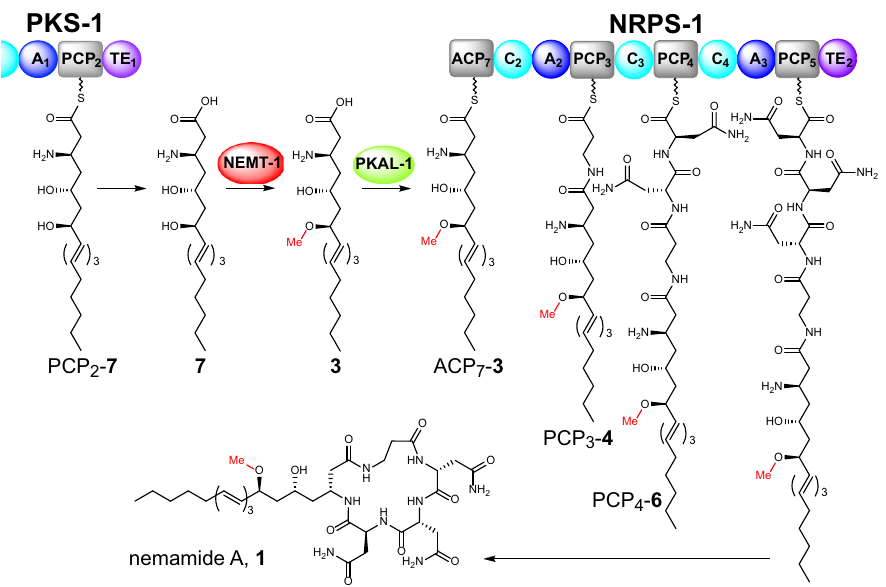
Fig. 6 Proposed model for the biosynthesis of the nemamides. The methylated intermediate 3 is activated by PKAL-1 as the adenylate and loaded onto the ACP 7 domain of NRPS-1 in order to biosynthesize nemamide A, 1 . An analogous pathway biosynthesizes nemamide B, 2 . Our data suggest that PKS-1 produces and releases 7 , which is then methylated by NEMT-1 to generate 3 . However, it is also possible that NEMT-1 acts earlier in the pathway on a polyketide intermediate attached to PKS-1, such that PKS-1 produces and releases 3 , not 7 (see “ Discussion ” ). Domain abbreviations: acyl carrier protein (ACP), peptidyl carrier protein (PCP), adenylation (A), condensation (C), and thioesterase Supplementary Table 4, and the PCR products were analyzed by restriction site digestion, as shown in Supplementary Table 5. Single worm PCR and CRISPR – Cas9 . Most mutant strains containing deletions and point mutations were generated based on the Fire lab ’ s CRISPR – Cas9 protocol 43,44 . The concentration of the Cas9 vector used was 50ng/µL. The plasmid for expressing the dpy-10 sgRNA was used at 25ng/µL, and the other plasmids for expressing the sgRNA sequences for target genes were used at 50 – 100 ng/µL (see Supplementary Table 6 for sequences). The dpy-10(cn64) donor oligonucleotide was used at a concentration of 500 nM, and other donor oligonucleotides for generating desired mutations were used at 500 – 750 nM (see Supplementary Table 7 for sequences). To generate deletion mutants, no donor oligonucleotide was used for either dpy-10 or targeted genes. After microinjection, F1 worms with dpy (for deletions) and roller (for point mutations) phenotypes were picked for single worm PCR using the primers listed in Supplementary Table 4 and restriction digestion (only for mutants with point mutations) of the PCR products as shown in Sup- plementary Table 5. The PCR products of positive candidates were sequenced to con fi rm their alleles, and dpy worms were backcrossed with wild-type (N2) worms. The nrps-1(reb32[A 2 _G964D]) and nrps-1(reb31[A 3 _G2337D]) strains were generated using the Mello lab ’ s CRISPR-Cas9 protocol 45 . All reagents to generate the Cas9 ribonucleoprotein (RNP) complex were ordered from IDT. Each injection Supplementary Table 7 for sequences), and 40ng/ μ L pRF4 (rol-6(su1006)) . The RNP complex was generated by incubating Cas9, tracrRNA, and crRNA for 15min at 37°C. The ssDNA donor and pRF4 (rol-6(su1006) were combined with the RNP and centrifuged at 16,000 × g for 5min. After microinjection, F1 worms exhibiting the roller phenotype were picked for single worm PCR using the primers listed in Supplementary Table 4 and subsequent restriction digestion of the PCR products as shown in Supplementary Table 5. The PCR products of positive candidates were sequenced to con fi rm their alleles. Transgenesis . Transcriptional reporter plasmids were made by amplifying the promoter from genomic DNA using the primers in Supplementary Table 8 and inserting the product into pPD114.108. Translational reporter plasmids were made by amplifying the promoter and gene from genomic DNA using the primers in Supplementary Table 8 and inserting the product into pBS77-SL2-mCherry. The reporter plasmids were injected into the corresponding mutant worm strains at 50 ng/µL. The coel::dsred plasmid was used as a co-injection marker at 25ng/ μ L, and the total concentration of DNA injected was 100 ng/ μ L including pUC18. At least three independent transgenic lines were analyzed.